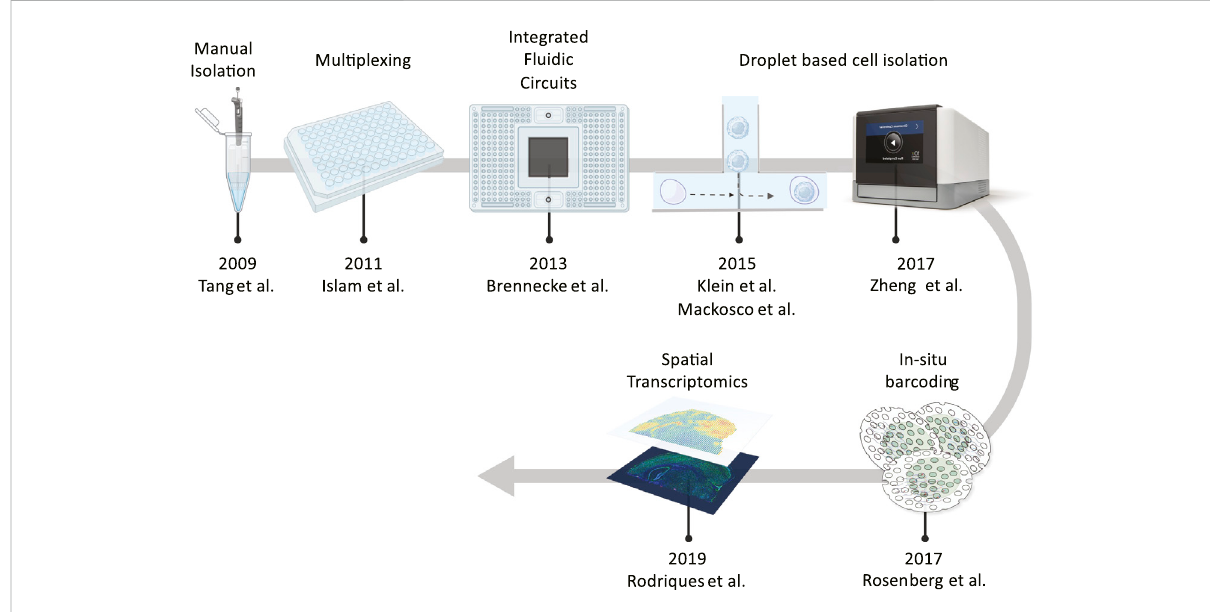
FIGURE 1 Noteworthy technologies that have allowed to pro fi le large numbers of cells in parallel. Starting from manual isolation methods, a jump to ~100 cells was enabled by sample multiplexing and than the development of integrated fl uidic circuits increased these numbers to an order of magnitude. Next, the introduction of nanodroplet technologies increased throughput even further to hundreds of thousands of cells, as for in situ barcoding which favoured the development of spatial